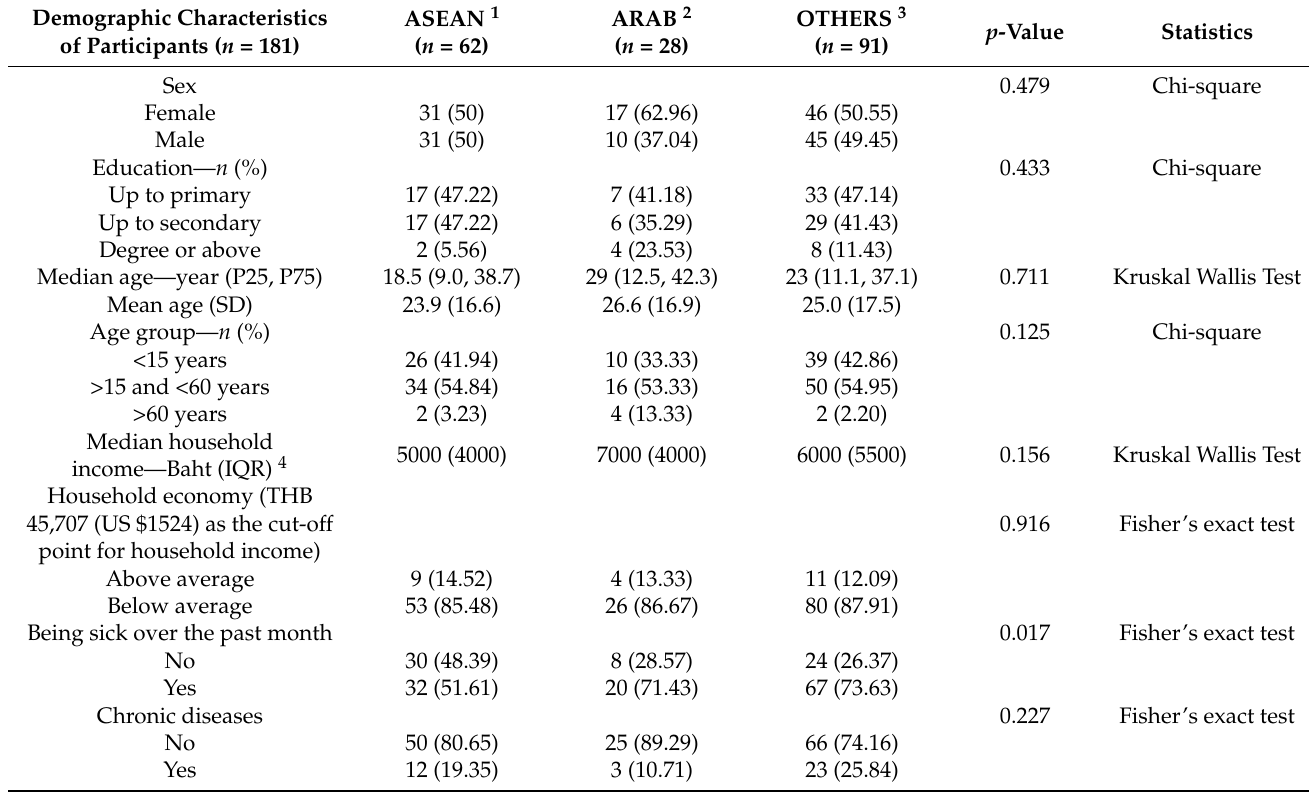
Table 1. Demographic characteristics of